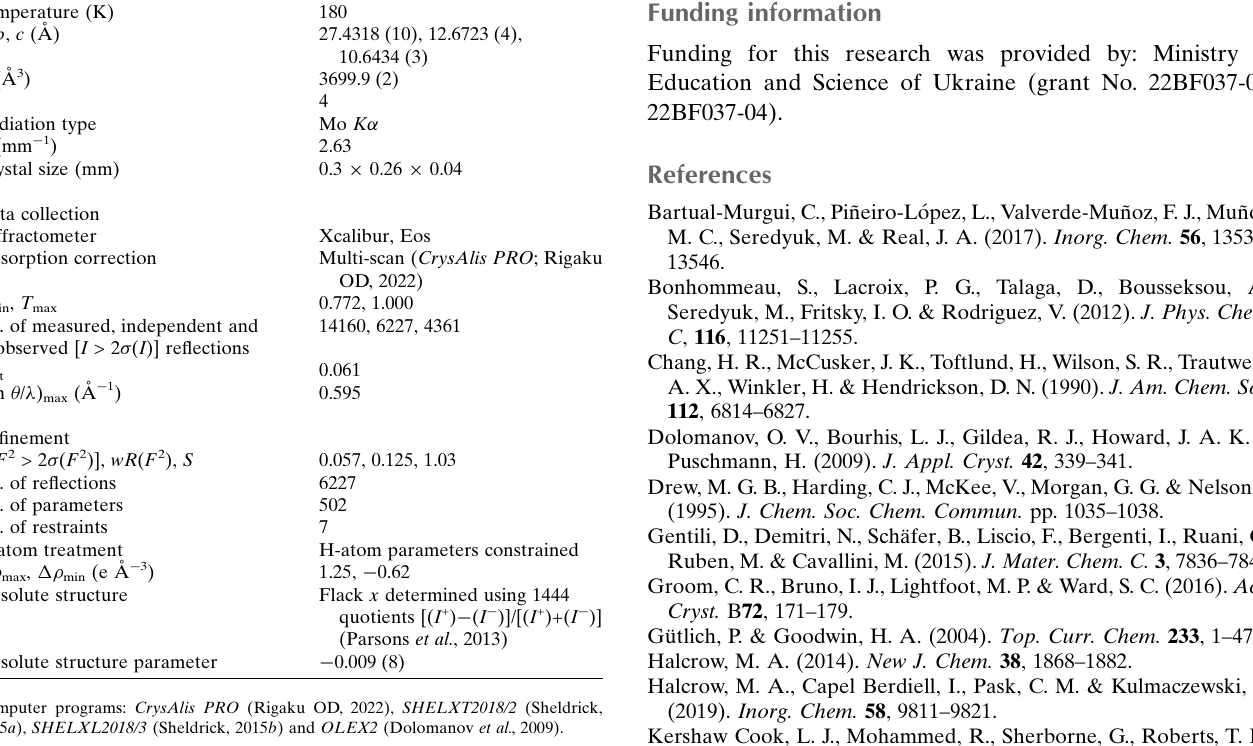
Table 3 Experimental details. Crystal data Chemical